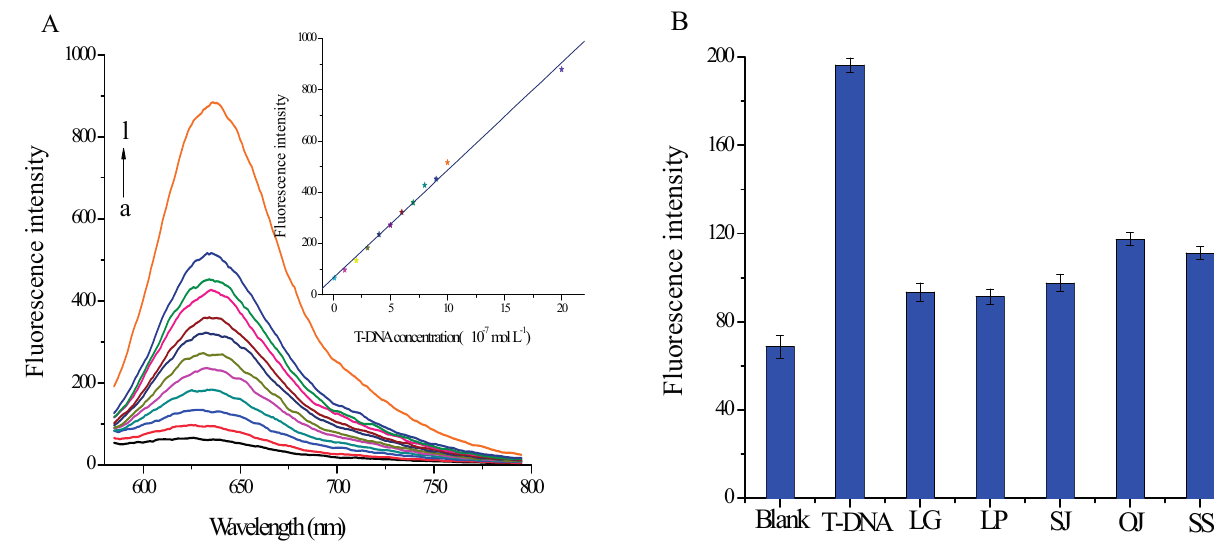
Figure 5. Fluorescence spectra of the split G-quadruplex/GO platform. ( A ) with T-DNA (a) 1.0 × 10 − 8 ; (b) 1.0 × 10 − 7 ; (c) 2.0 × 10 − 7 ; (d) 3.0 × 10 − 7 ; (e) 4.0 × 10 − 7 ; (f) 5.0 × 10 − 7 ; (g) 6.0 × 10 − 7 ; (h) 7.0 × 10 − 7 ; (i) 8.0 × 10 − 7 ; (j) 9.0 × 10 − 7 ; (k) 1.0 × 10 − 6 ; (l) 2.0 × 10 − 6 mol·L − 1 . Inset: derived calibration curve of the fluorescence intensity at 635 nm vs. T-DNA concentration; ( B ) in the absence of T-DNA or presence of T-DNA (3.0 × 10 − 7 mol·L − 1 ) or C-DNA (3.0 × 10 − 7 mol·L − 1